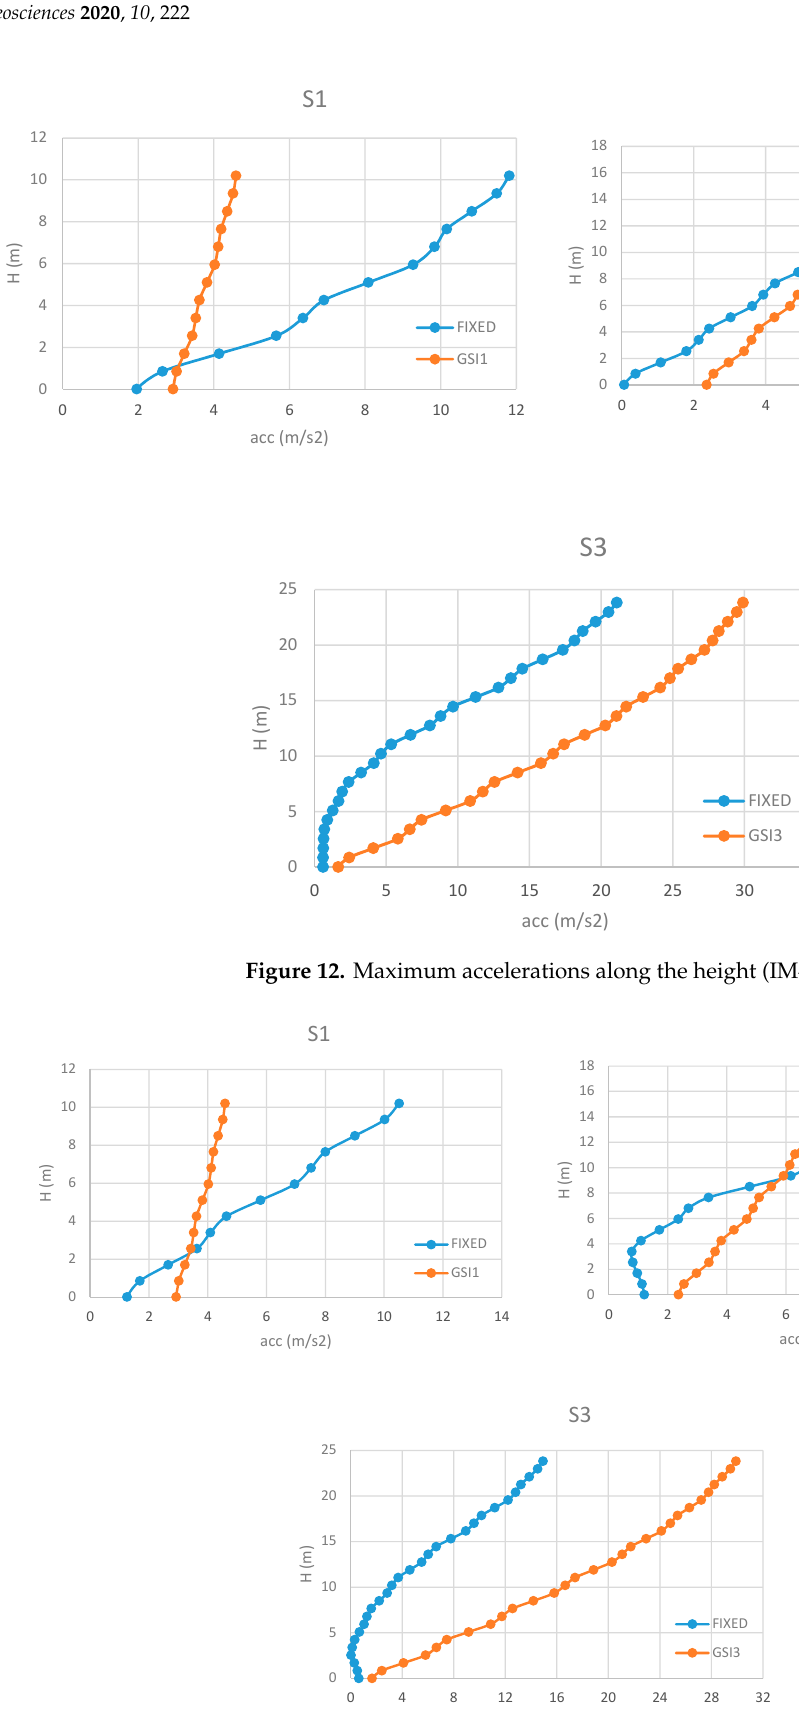
Figure 11. Maximum accelerations along the height (IM3).